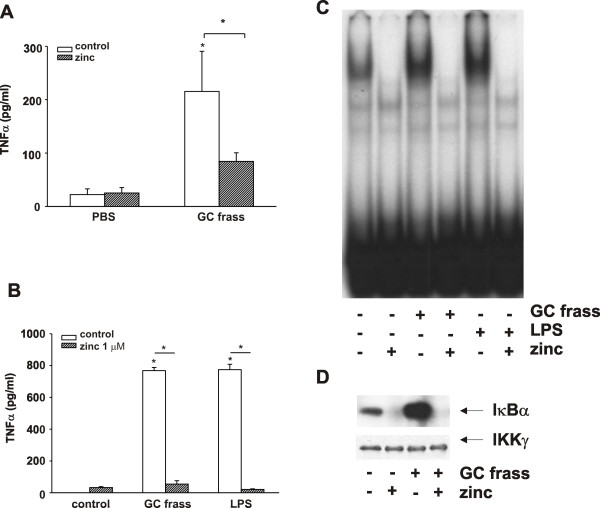
Zinc supplementation decreased neutrophil-derived cytokine production via decreased NF-κB activation. A. Bone marrow-derived neutrophils were isolated and treated with GC frass (1 μg/ml) or LPS (1 μg/ml) with or without zinc gluconate (1 μM) and pyrithione (10 μM) for 18 h. Supernatants were clarified and analyzed by ELISA for TNFα production. Data are means ± SEM (n = 3 separate experiments) and statistical differences assessed by ANOVA (*p < 0.05). B. HL-60 cells were treated as in A and analyzed by ELISA for TNFα production. Data are expressed as mean ± SEM for four experiments (*p < 0.001). C. Zinc supplementation decreased NF-κB-DNA binding. HL-60 cells were stimulated with GC frass or LPS in the presence of zinc and pyrithione for 4 h. Nuclear extracts were analyzed for NF-κB-DNA binding by EMSA. D. Zinc supplementation decreased IKK activity. HL-60 cells were cultured with or without zinc gluconate and pyrithione prior to treatment with GC frass for 1 h. IKK activation was assessed by in vitro kinase assay using recombinant IκBα as a substrate. PBS treated (P) and GC frass treated (F) cells cultured with and without zinc.